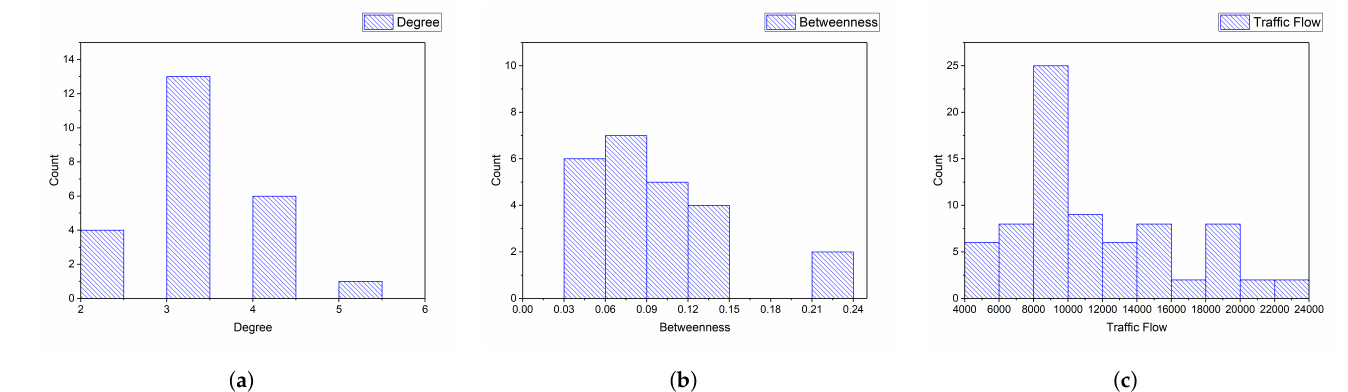
Figure 2. Basic statistics for traffic network of Sioux Falls, ( a ) Degree distribution, ( b ) Betweenness distribution, ( c ) Traffic flow distribution.